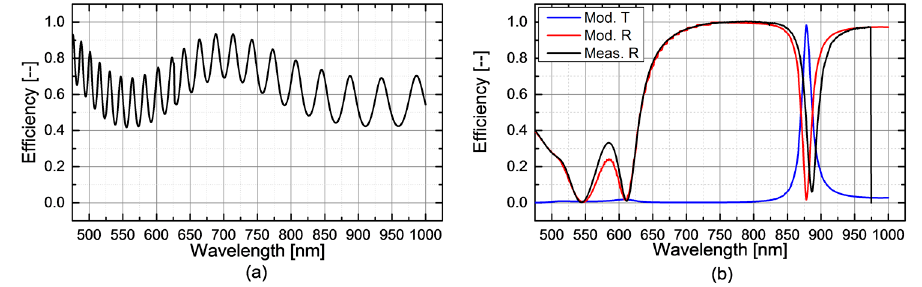
Figure 6. ( a ) Simulated transmission spectrum of the cavity/Oxide lid stack, ( b ) proposed